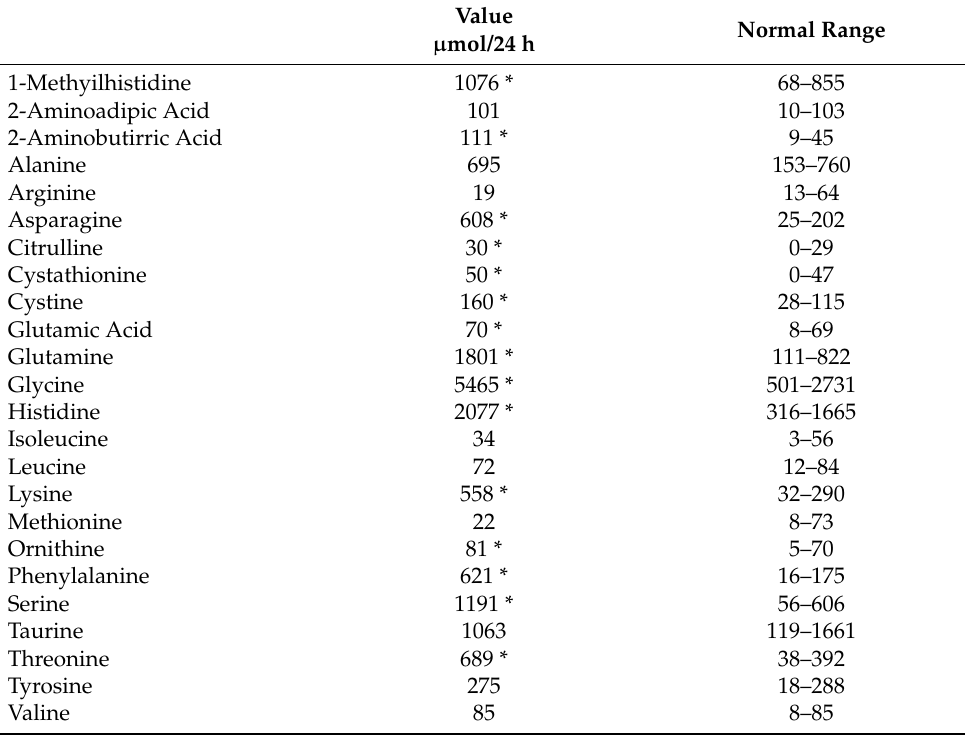
Table 2. Aminoaciduria (* indicates out of range